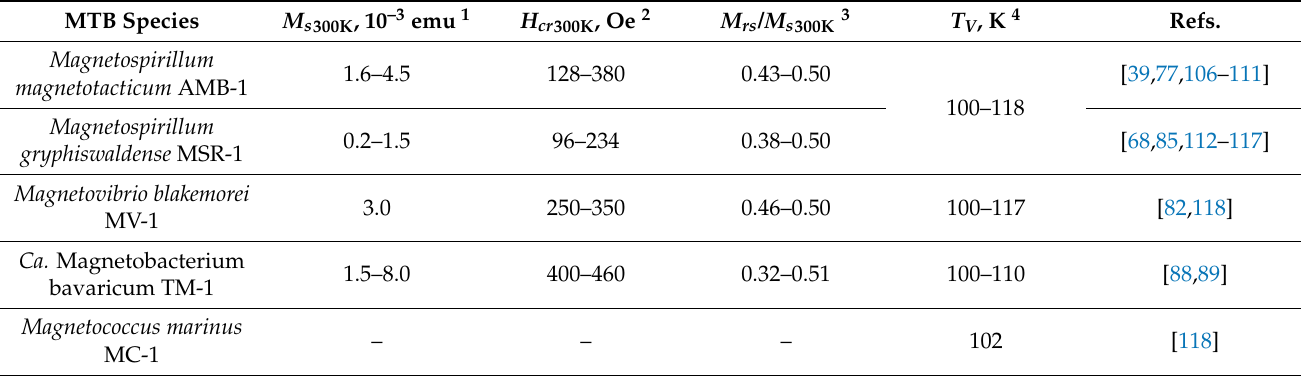
Table 2. Magnetic characteristics of magnetosomes isolated from MTB of some species MTB Species